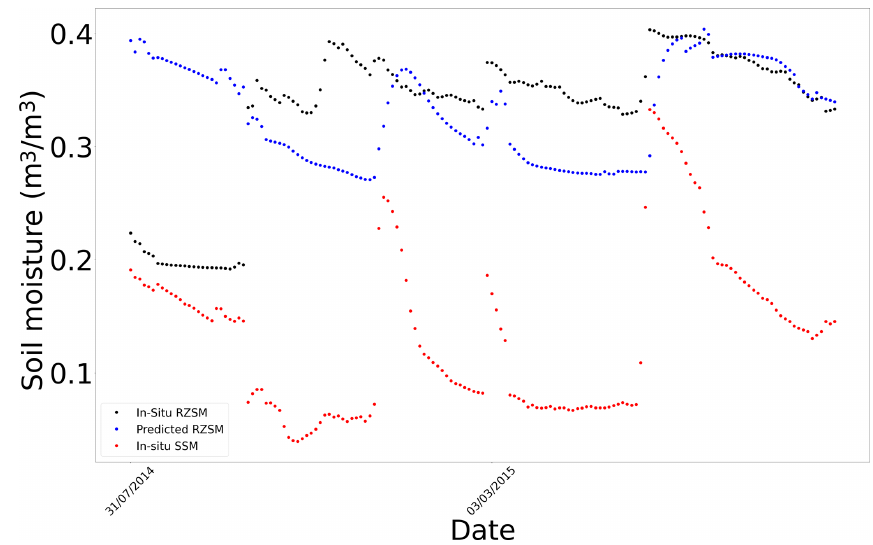
Figure F6. In situ SSM, in situ RZSM, and predicted RZSM series at station S-Coleambally with model ANN_SSM_NDVI_EVAP-EFF-